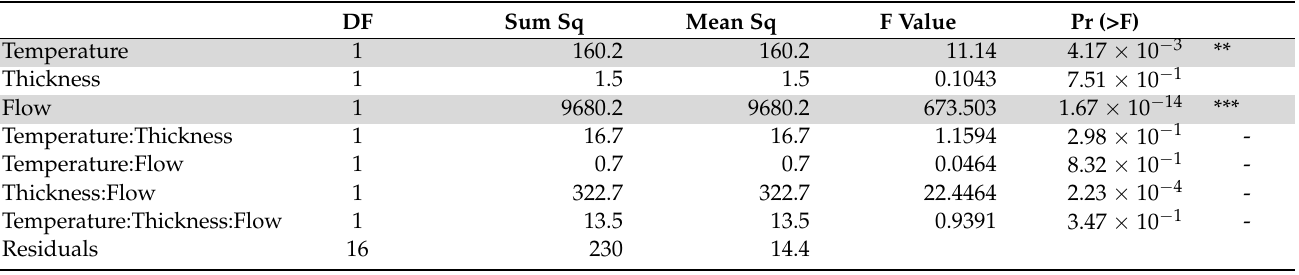
Table 9. Statistical significance of the effects of the printing parameters and their interactions on samples tensile yield strength.